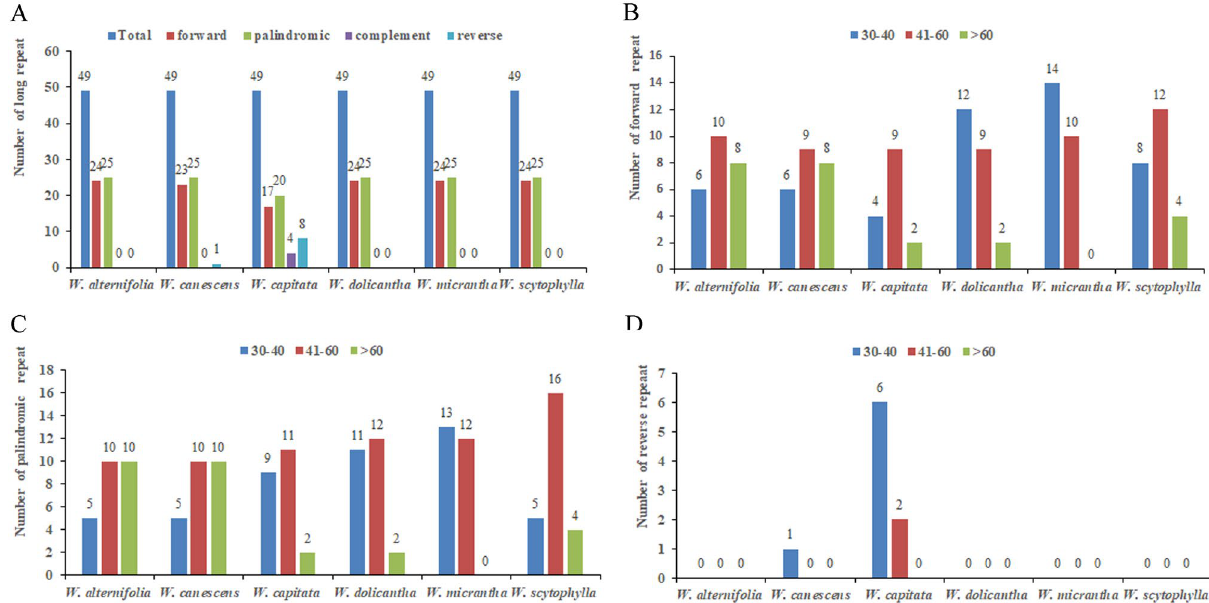
Figure 3. Analysis of long repeat sequences in the plastomes of six species of Wikstroemia . ( A ) Quantities of long repeats based on type; ( B ) frequencies of forward repeats by length; ( C ) frequencies of palindromic repeats by length; and ( D ) frequencies of reverse repeats by length.